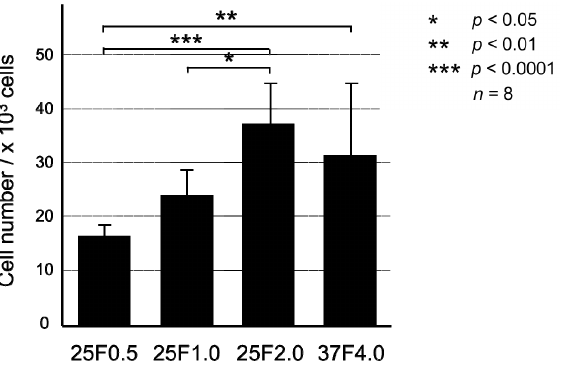
Figure 5. Number of NIH3T3 cells extracted with citric acid buffer after culture for 72 h in serum-free medium from the FGF-2-apatite composite layers of the 25F0.5, 25F1.0, 25F2.0, and 37F4.0